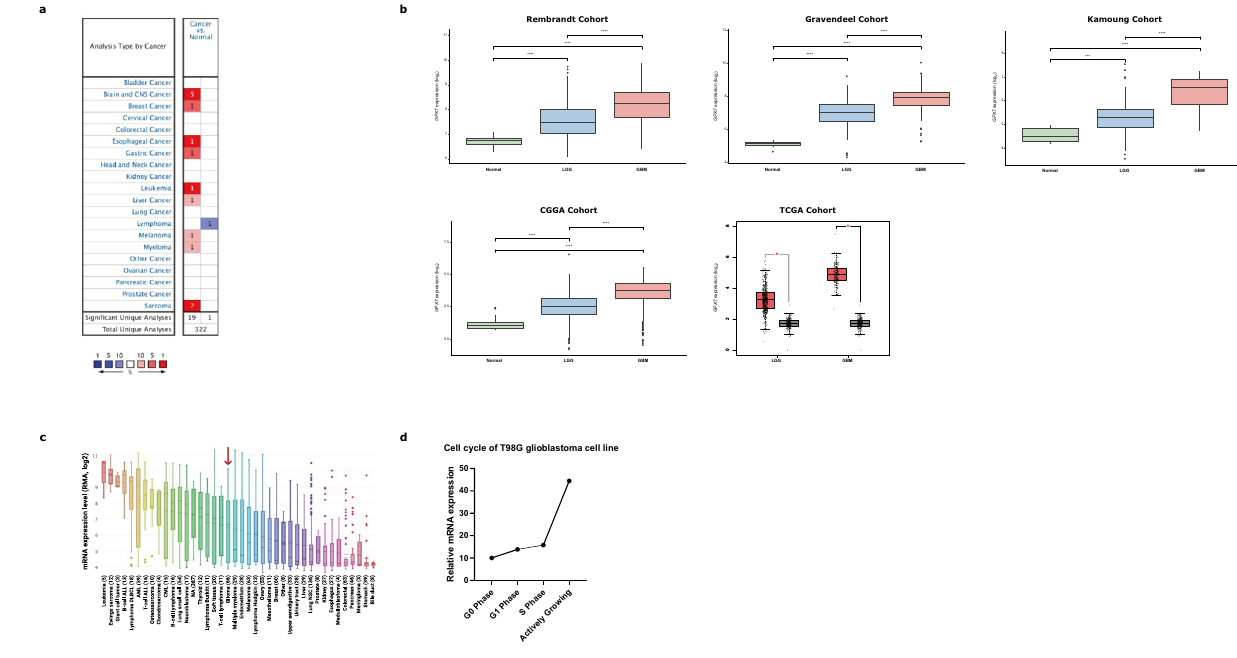
Figure 1. Transcription levels of GPX7 in different types of human cancers compared with normal tissues (Oncomine database). ( a ) The number of datasets with statistically significant mRNA upregulated (red) or downregulated expression (blue) of GPX7 . The numbers in the colored cell represent datasets meeting the threshold (see “Material and methods”). The gene rank was analyzed by the percentile of the target gene at the top of all genes measured in each research. The cell color is determined by the best gene rank percentile for the analyses within the cell. Significant Unique Analyses indicate that the queried gene is significantly different in studies. Total Unique Analysis indicates the total number of studies that contain the queried gene. ( b ) GPX7 expression levels in distinct glioma cohorts. Rembrandt microarray cohort (Normal samples = 28 samples; LGG samples = 225 samples; GBM samples = 219 samples); Gravendeel microarray cohort (Normal samples = 8 samples; LGG = 117 samples; GBM = 159 samples); Kamoun microarray cohort (Normal samples = 9 samples; LGG = 154 samples; GBM = 16 samples); Chinese Glioma Genome Atlas (CGGA) RNA-seq cohort (Normal samples = 20 samples; LGG = 625 samples; GBM = 388 samples); TCGA RNA-seq cohort (LGG = 518 samples; GBM = 163 samples). Red boxplots: Tumor samples from TCGA. Grey boxplots: Normal samples from GTEx (Genotype–Tissue Expression database) (N = 207 samples). ( c ) mRNA expression of GPX7 in different types of cell lines of human cancer from CCLE (Cancer cell line encyclopedia). The red arrow indicates the glioma cell lines (66 cell lines). The number next to the lineage name represents the number of cell lines in the lineage. The expression ranks in gliomas using Affymetrix GeneChip data. Statistical significance is denoted by * p < 0.05, ** p < 0.01, *** p < 0.001. ( d ) GPX7 gene expression profiling during the cell cycle in T98G cells (Human Glioblastoma Cell line) (GDS3364 from GSE8537 dataset) 35 .